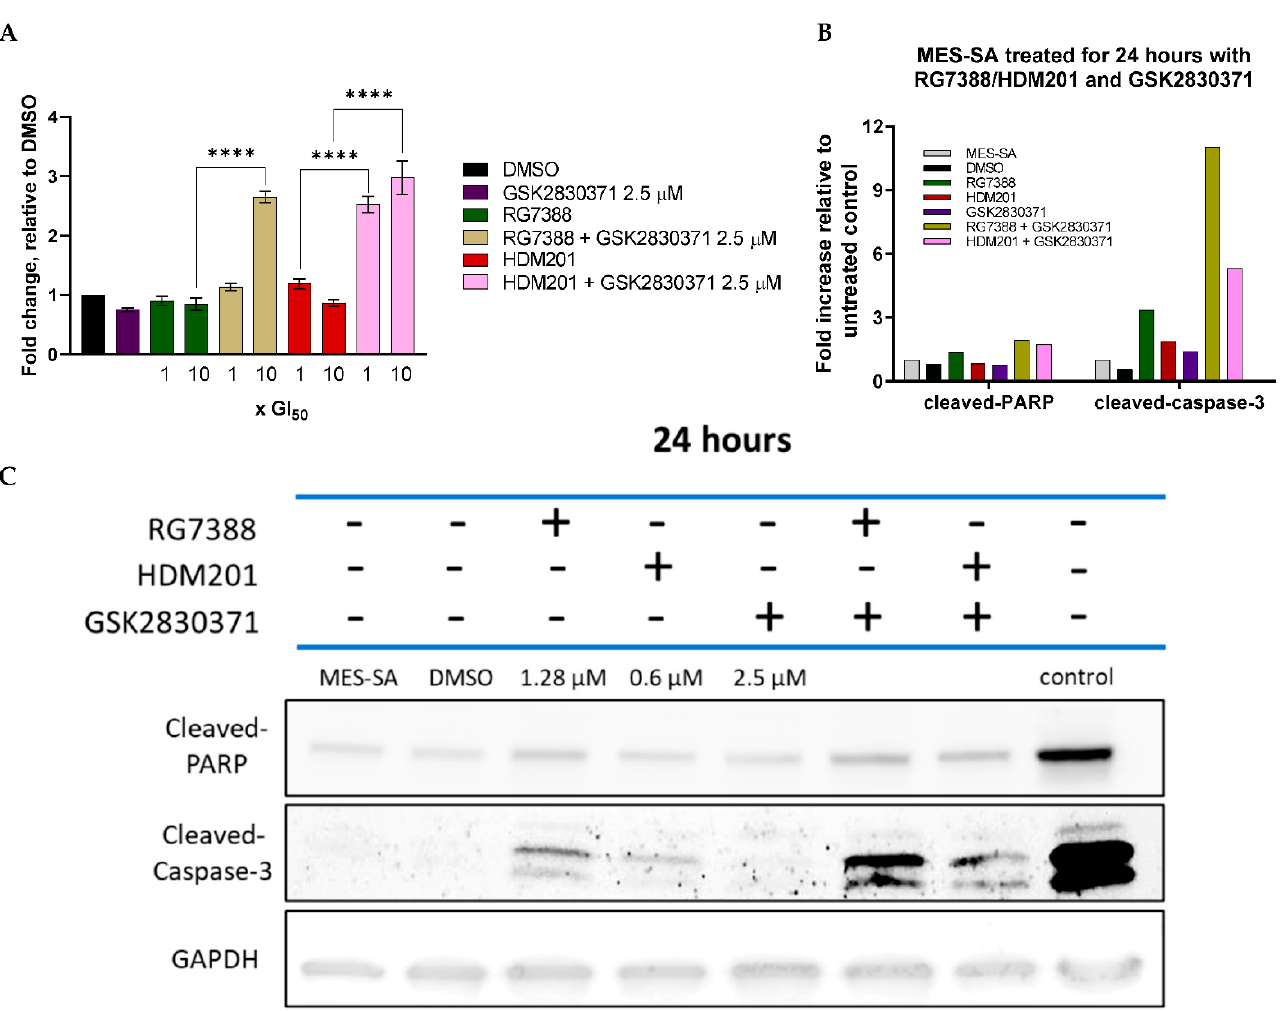
Figure 8. ( A ) Caspase-3/7 catalytic activity in MES-SA cells following 24 h treatment with either RG7388, HDM201 or GSK2830371 as single agents and in combination. Data are expressed as the mean fold change relative to DMSO-treated control, calculated from three independent repeats. Statistical significance was evaluated by a one-way ANOVA with Tukey’s post hoc test for multiple comparisons. **** p ≤ 0.0001. ( B ) Western Immunoblot of MES-SA cells treated for 24 h with RG7388, HDM201 and GSK2830371. Positive control was SH5Y5Y cells collected 4 h post X-irradiation with 2 Gy (provided by A. Yagbassan). Doses of RG7388 and HDM201 represent 10 × their GI 50 concentrations. All strips were from the same membranes, which were cut into three. The top strip was probed for cleaved-PARP, the middle GAPDH, and the bottom cleaved-caspase-3. ( C ) Densitometry. Values were corrected for background signal, normalised to GAPDH, and then fold change was expressed relative to untreated control. The positive control was not included in the densitom- etry